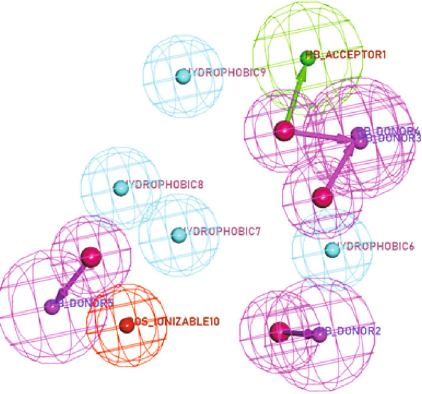
Figure 3: The generated hypothetical 3D-pharmacophore geometry with targeted pocket features; aromatic ring or hydrophobic (blue), ionic center (orange), hydrogen bond donor (violet), and acceptor center (green). (a) Queries of generated